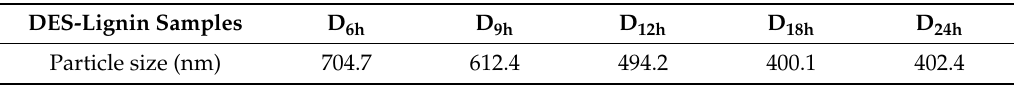
Table 4. Particle size of DES-lignin samples (D 6h , D 9h , D 12h , D 18h , D 24h ) extracted from willow by DES treatment at 120 °C for 6, 9, 12, 18, and 24 h.